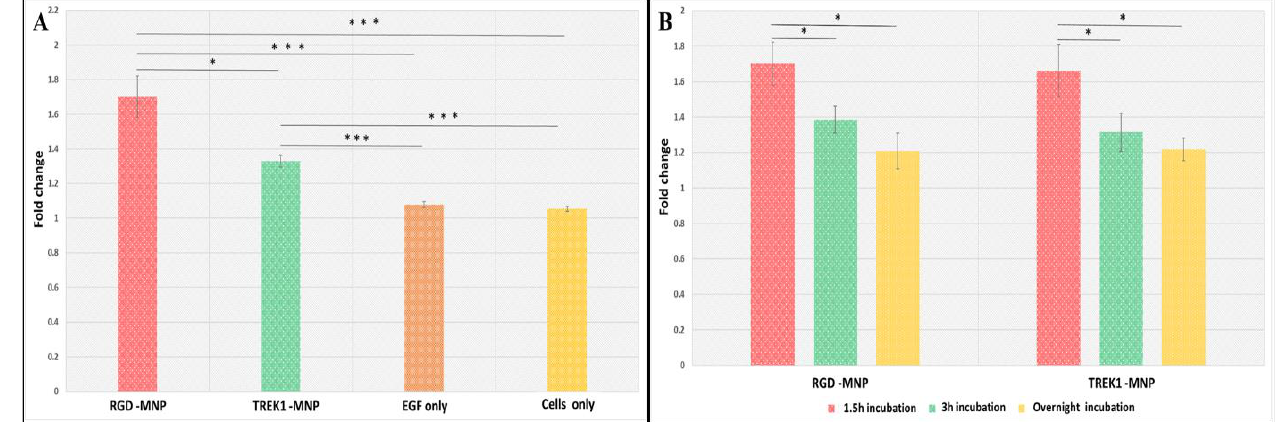
Figure 2. Luciferase assay exhibiting the ( A ) fold changes in the MEK/ERK pathway activation with RGD-MNPs and TREK1-MNPs, ( B ) effect of MNP incubation period (w/ and w/o MICA application, asterisks indicate significance in results using ANOVA test (* p <0.05, *** p < 0.0005)).